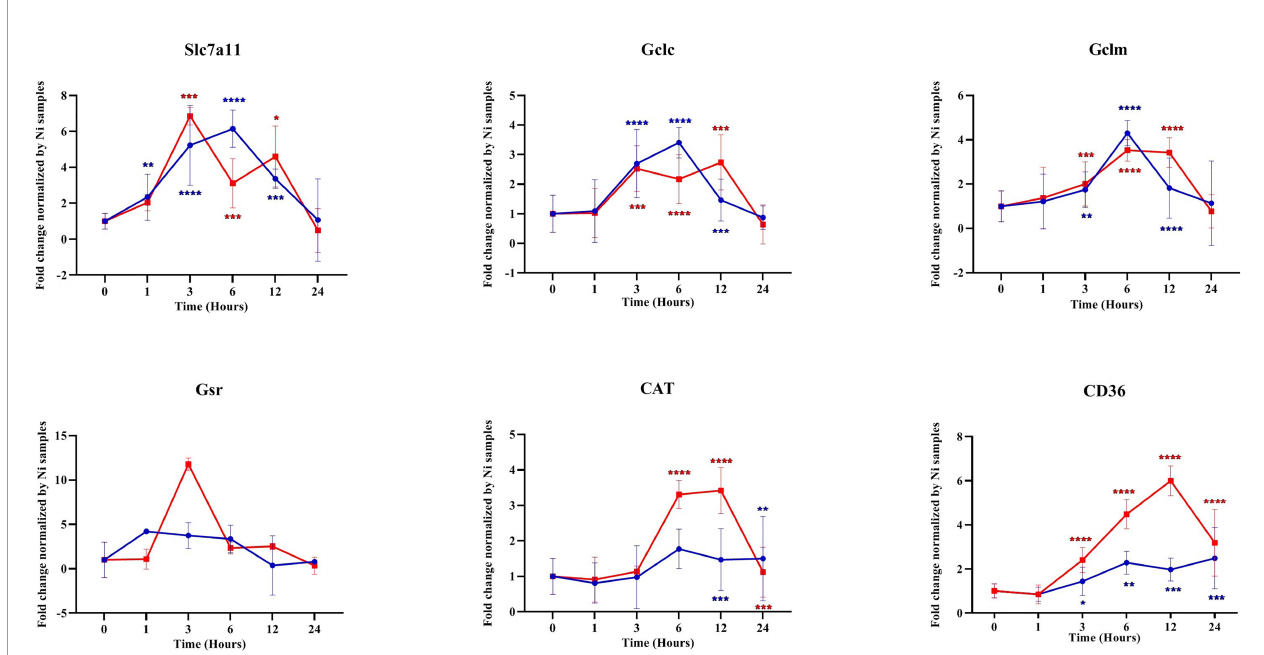
FIGURE 5 | Transcription of different antioxidant genes was repressed by parasites. Balb/c bone marrow-derived macrophages (BMdMs) were infected with live parasites ( P ) ( blue fi lled circle or heat-inactivated ( Kp ) ( red fi lled square ) L. major promastigotes for different times. RT-PCR targeting Slc7a11, GCLc, GCLm, Gsr, CAT, and CD36 was performed. The graphs show fold change results expressed as the mean ± SD from three independent experiments. * p < 0.05, ** p < 0.01, *** p < 0.001, **** p < 0.0001 vs . non-stimulated BMdMs (two-way